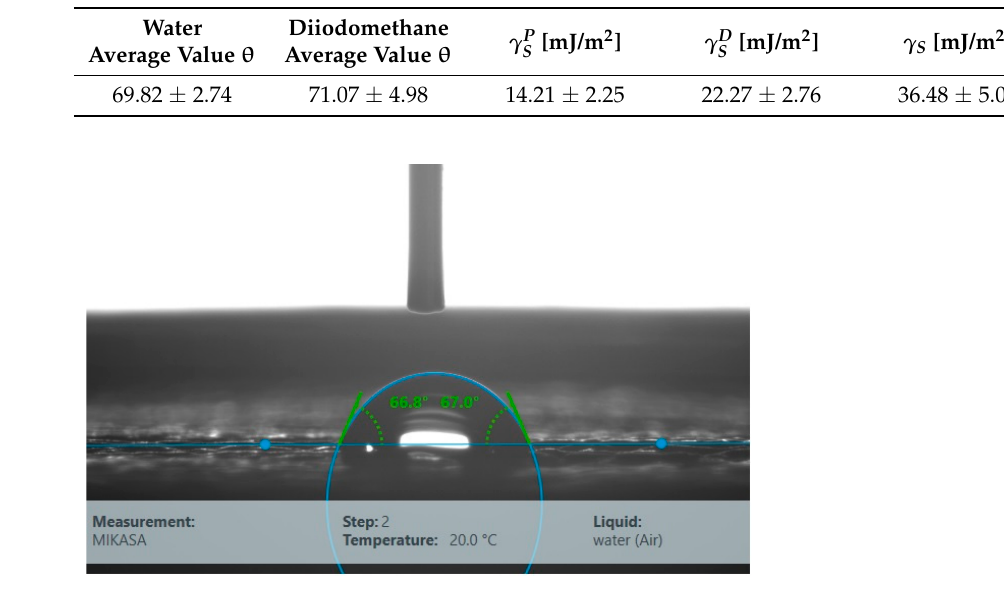
Figure 6. Determination of the contact angle of Mikasa. Table 2. The surface free energy for the Mikasa sample.